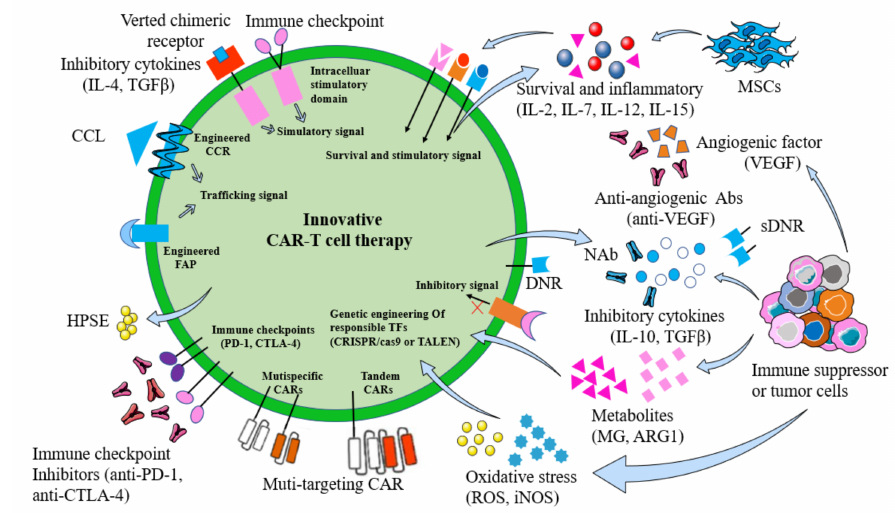
Figure 7. Ways to improve CAR-T-cell therapy.